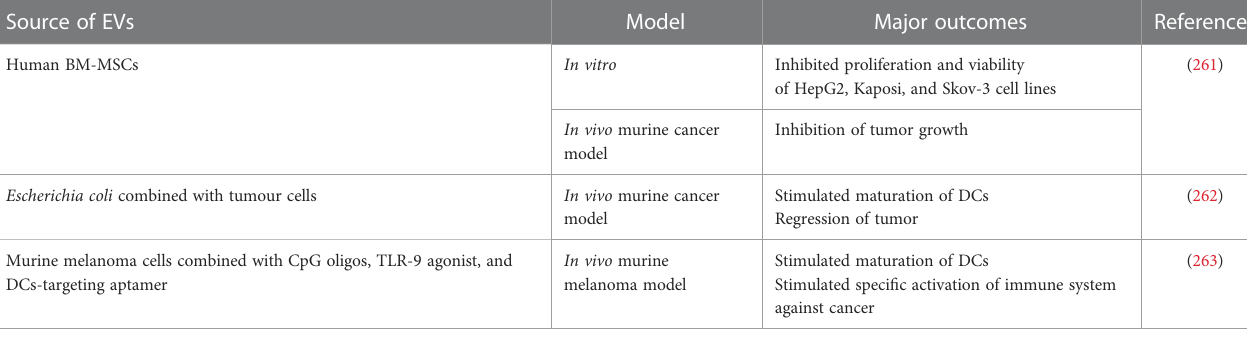
TABLE 11 Examples of EV use in preclinical studies related to the treatment of